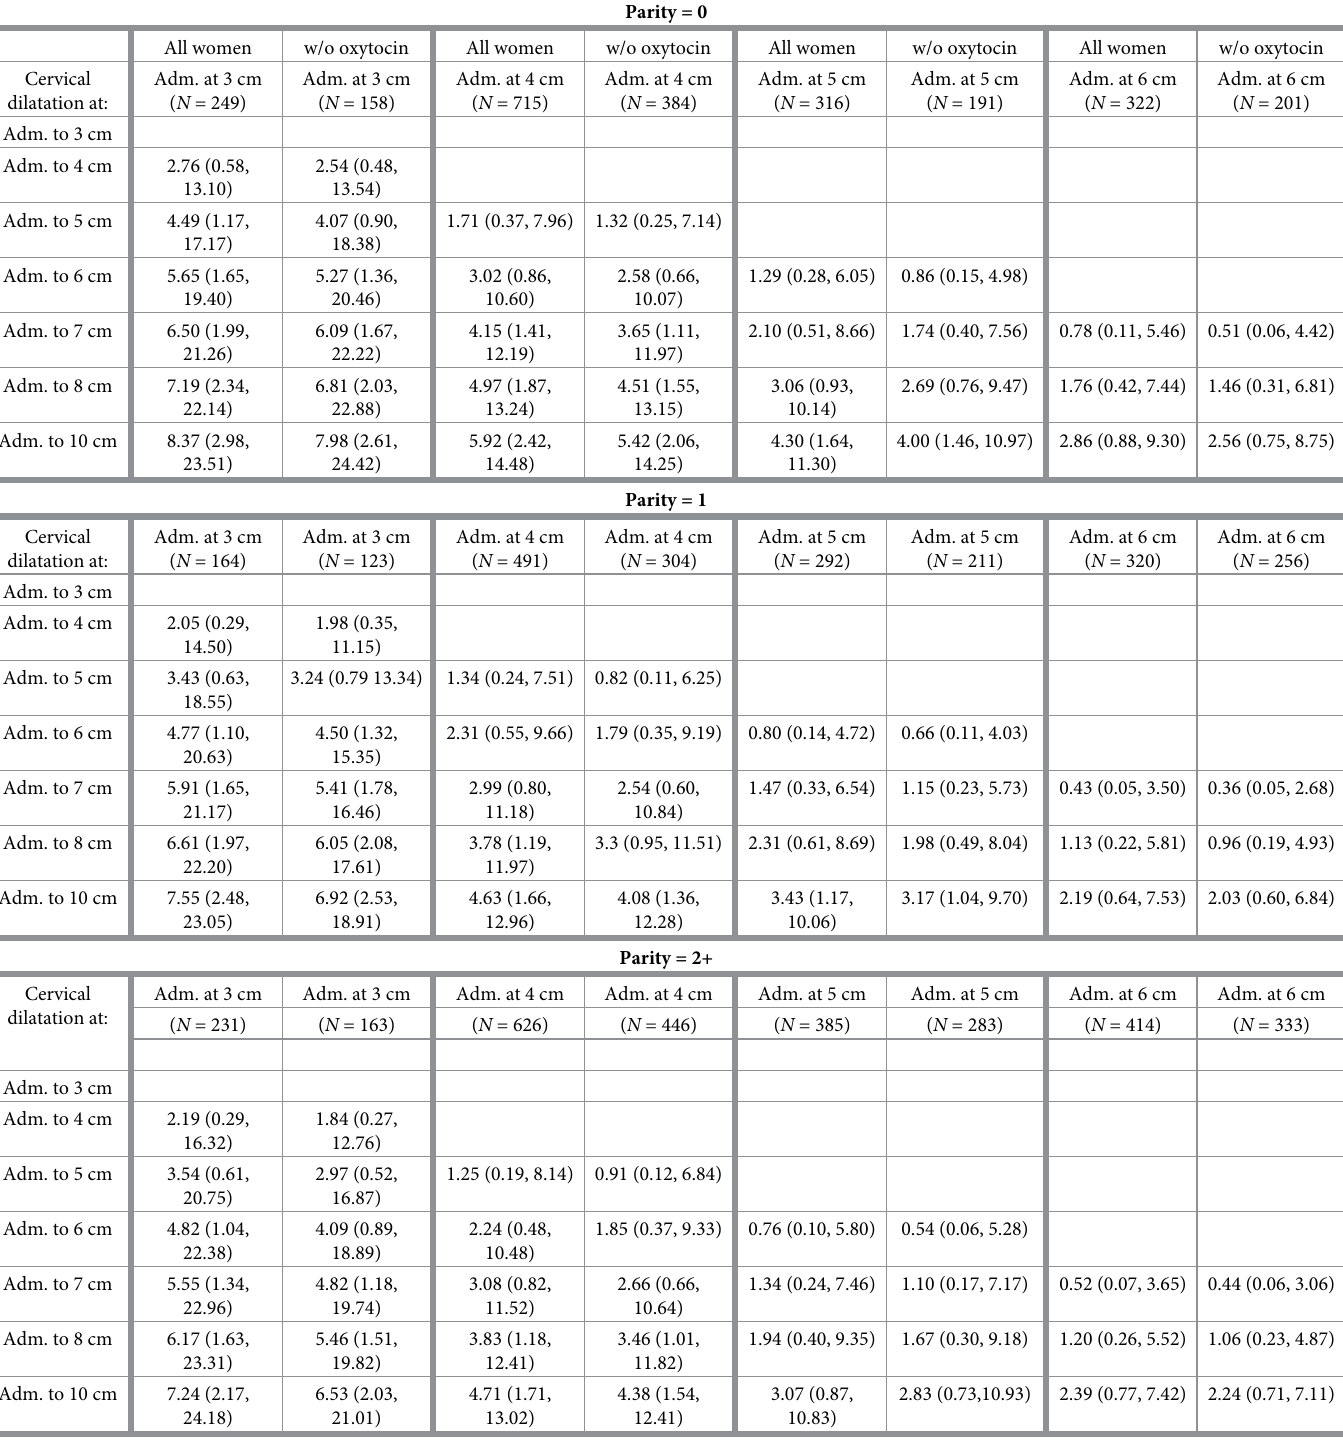
Table 5. Cumulative duration of labour in Para 0, 1, and 2+ based on the cervical dilatation at admission by use of oxytocin augmentation (survival analysis).